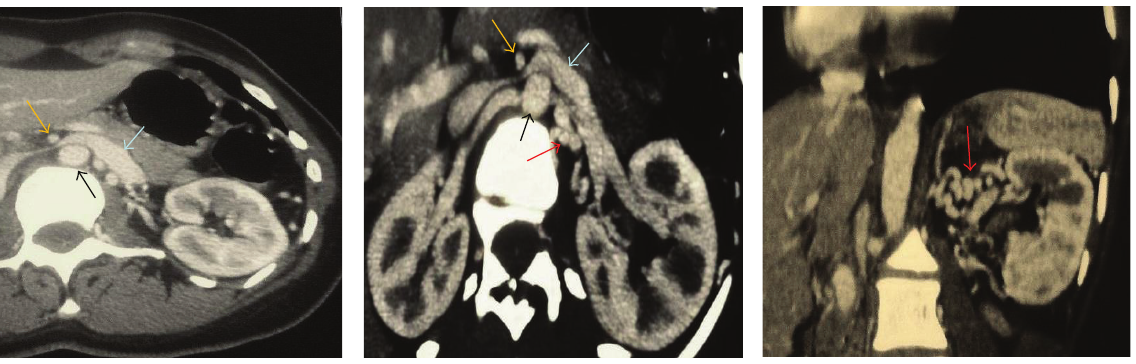
Figure 2: CTA of the abdomen and pelvis showed complete disappearance of the renal vein thrombosis and demonstrated the nutcracker syndrome: compression of the LRV between the aorta (black arrow) and the SMA (yellow arrow), with a dilatation of the hilar portion of the LRV (blue arrow). The red arrow showed and surrounding vascular